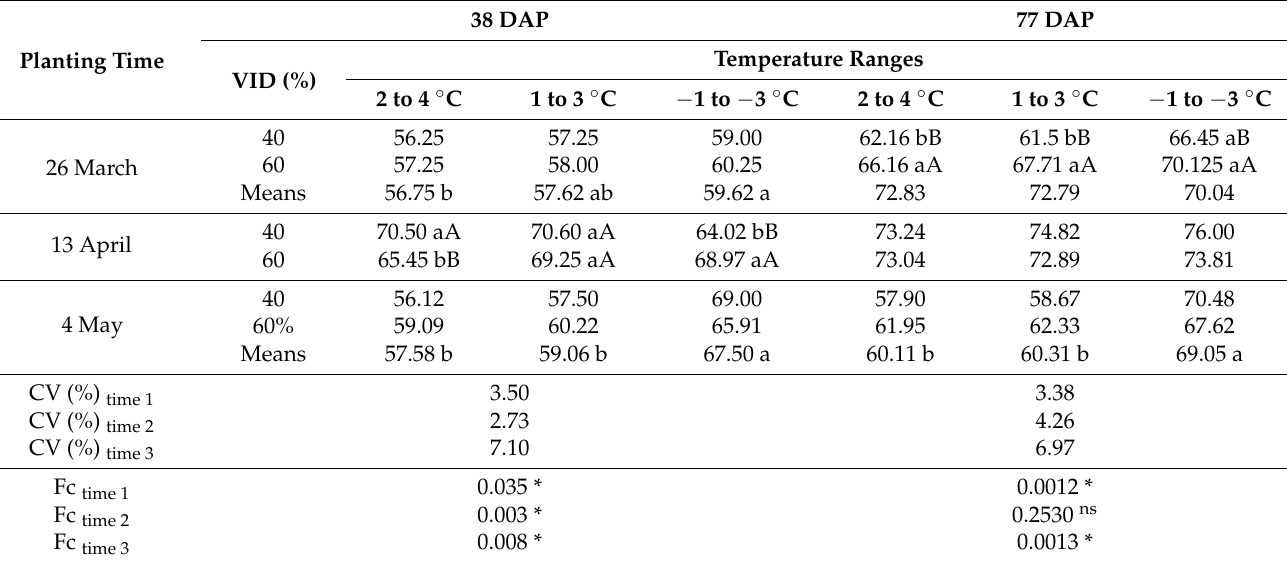
Table 4. Height of garlic plants of the Ito variety, at 38 and 77 days after planting (DAP), under different temperatures ranges and visual index of overcoming dormancy